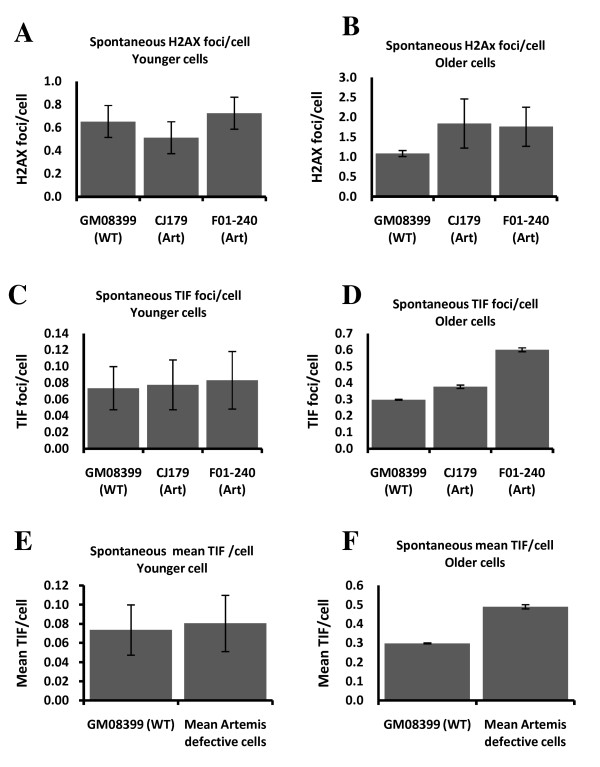
Frequencies of spontaneous γ-H2AX positive foci and TIFs in "younger" and "older" cells. A and B. Average γ-H2AX positive foci in each cell line. C and D. Average TIFs per in each cell line. E and F. Mean frequencies of TIFs from two Artemis defective cell lines pooled together. All results are based on four independent experiments with an average of 200 cell nuclei scored per experiments per cell line.